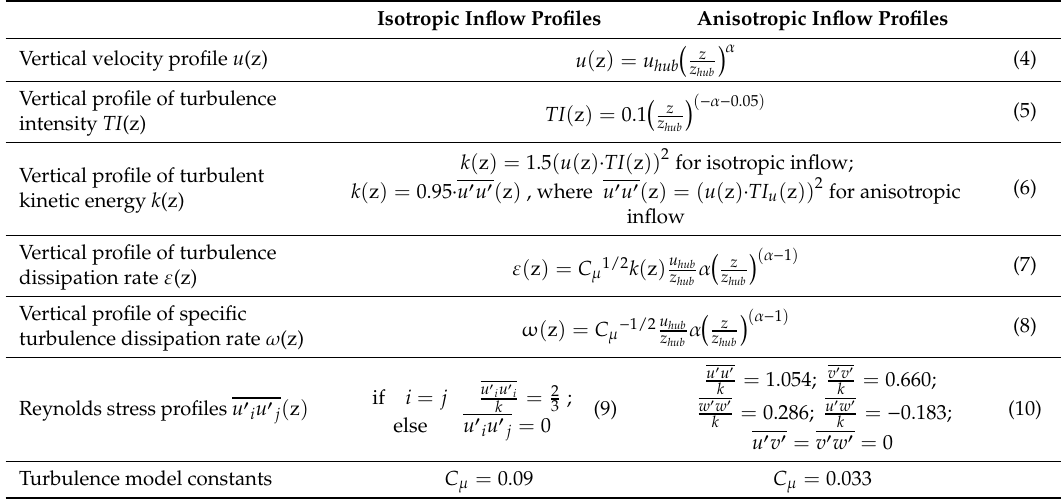
Table 2. Summary of adopted turbulence profiles required at the inlet and outlet